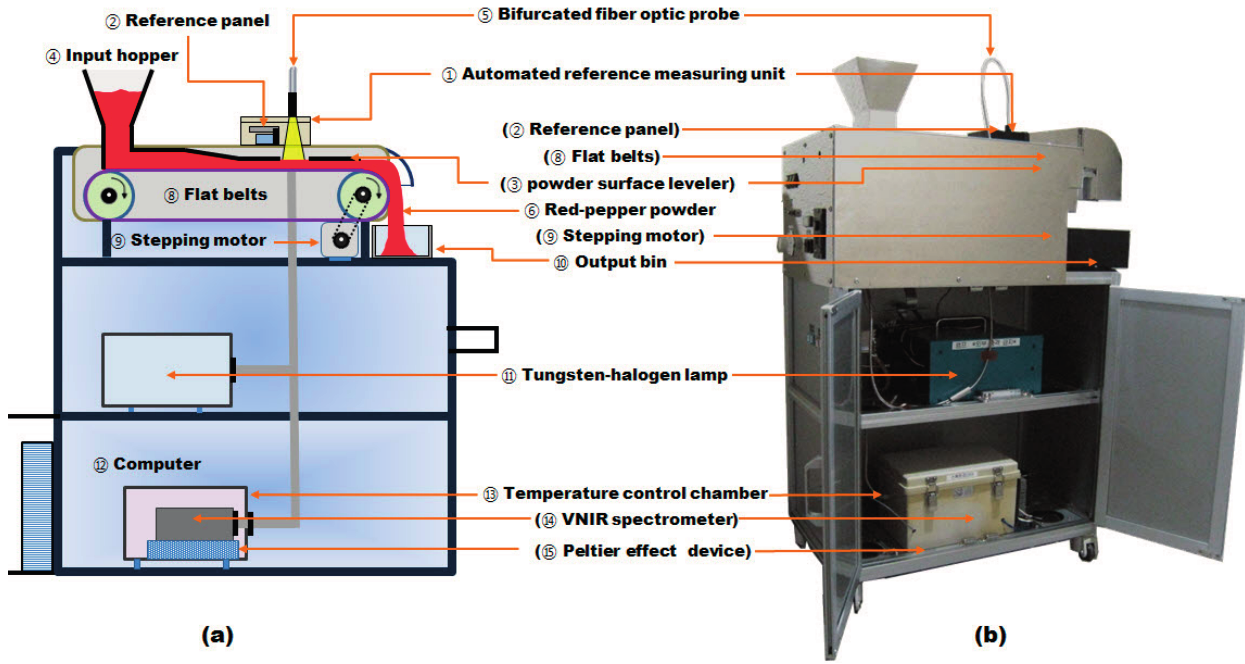
Figure 2. A schematic diagram ( a ) and photo ( b ) of the measurement system for the capsaicinoid content of red pepper